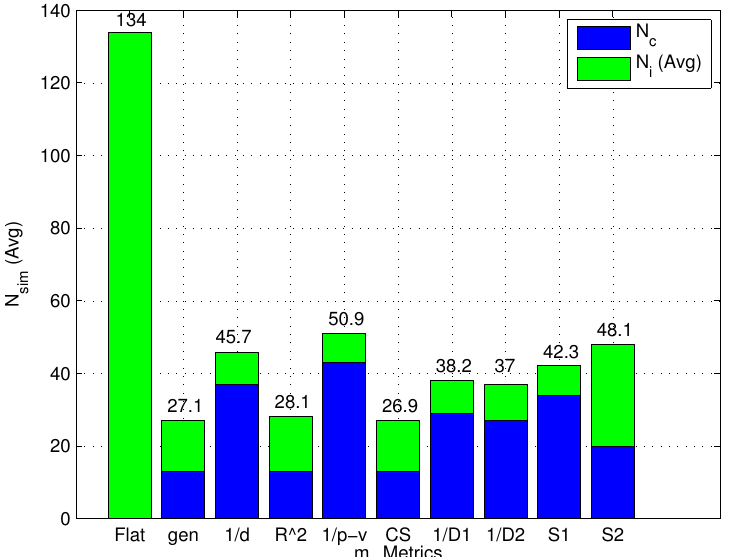
Figure 11. Impact of the m m /gen/ ( D 2 ) − 1 combinations. 1